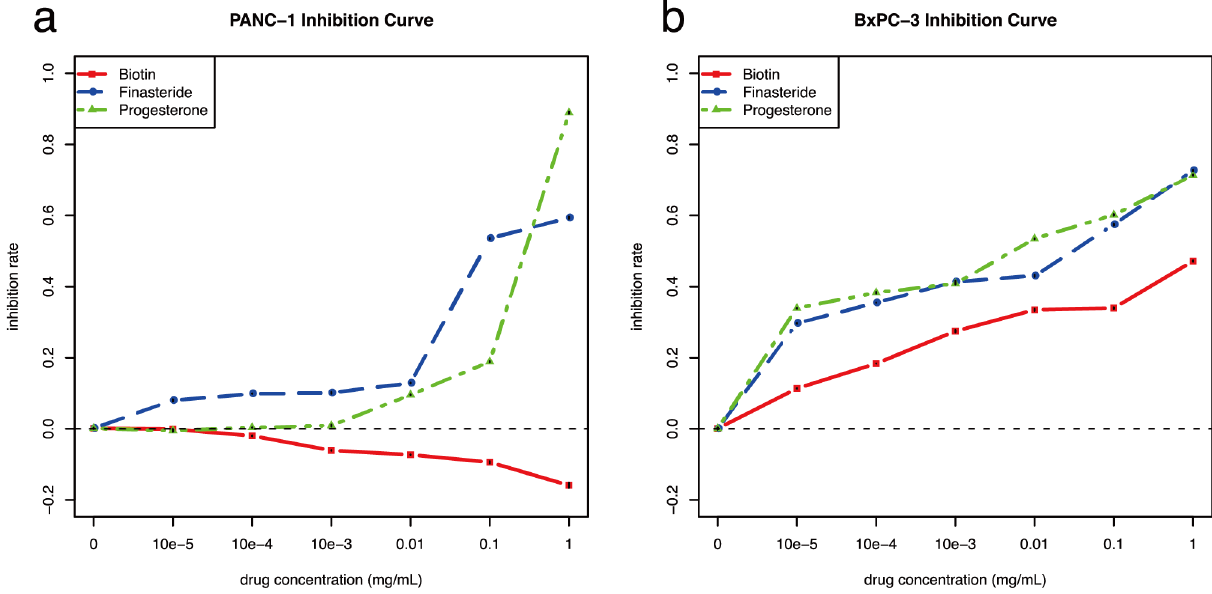
Fig 4. Drug inhibion rate on the Panc-1 pancreatic cancer cell line. A. Pancreatic cell line PANC-1. B. Pancreatic cell line BxPC-3. X and Y coordinates denote concetration and inhibition rate of the three drugs, Biotin, Finasteride and Progesterone. Short line segments on the points denote the variation of three